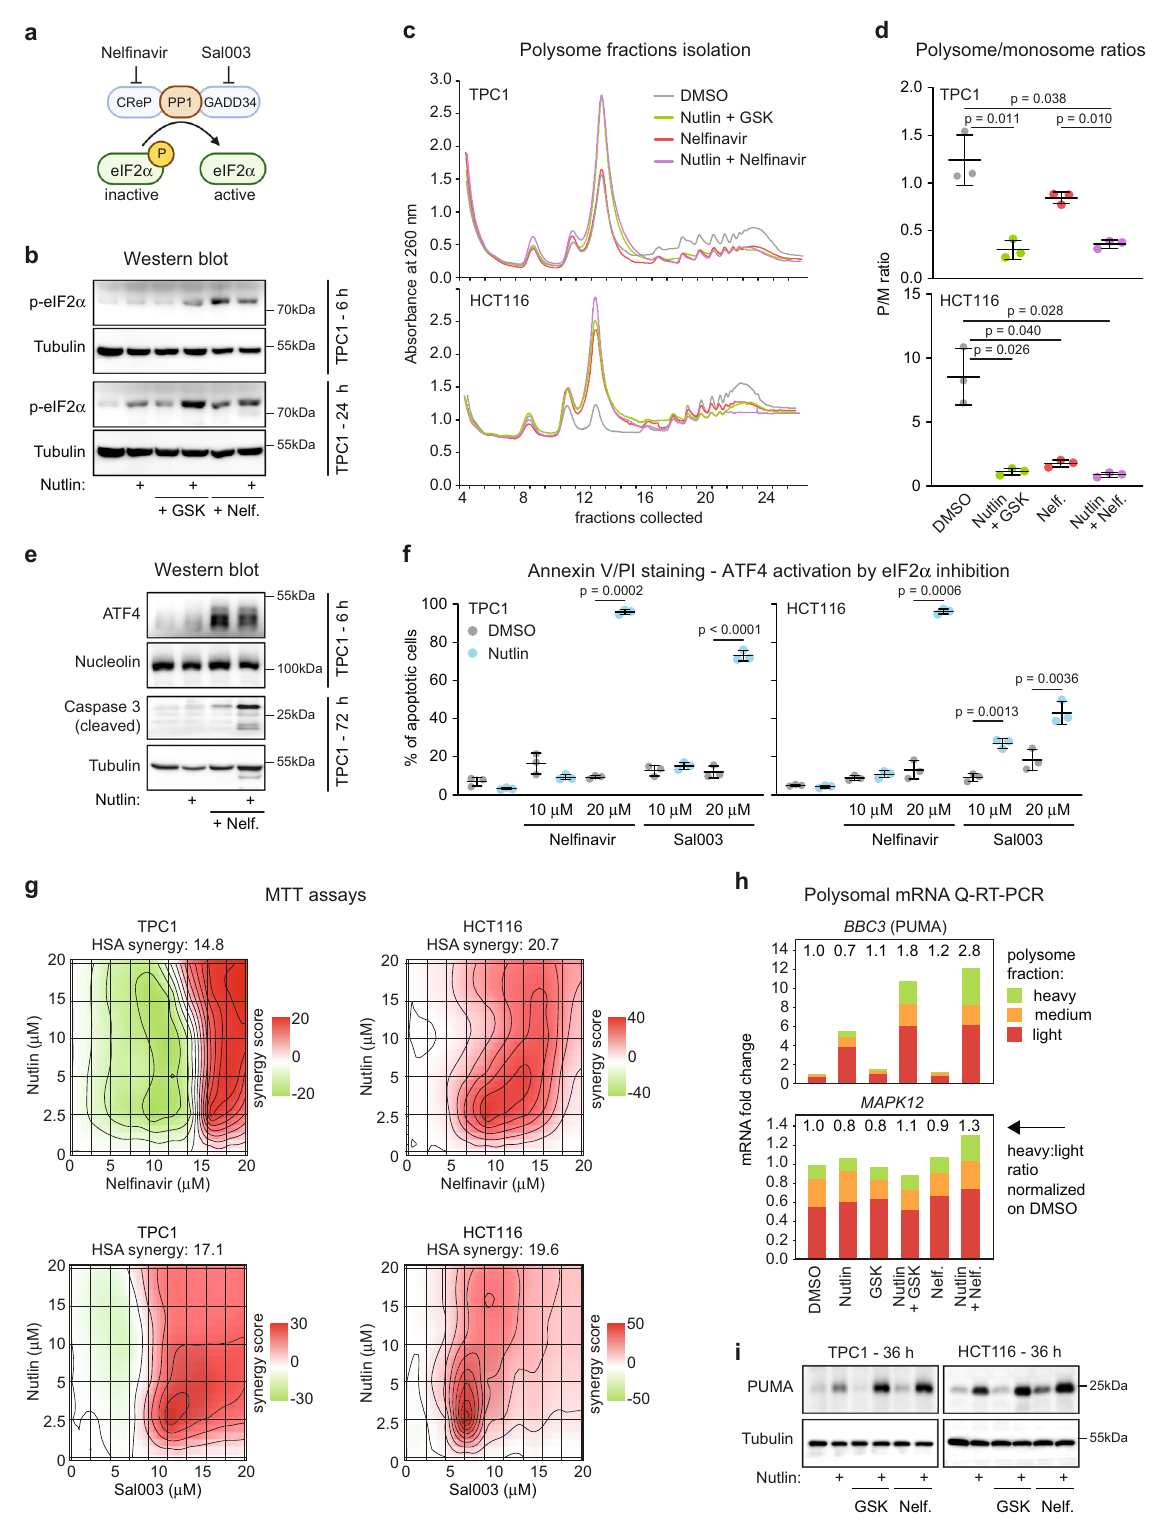
week using caliper measurements and formula v =( l × w 2 )/2, where l represents the greatest length of the tumor and w is tumor width in the perpendicular axis. Average volumes of the right and left fl ank tumors were used for plotting and calculations. Equal ratios of male and female mice were used in treatment groups (5 males and 5 females). All in vivo experiments were approved by the Institutional Animal Care and Use Committee at the CU-AMC (IACUC protocol